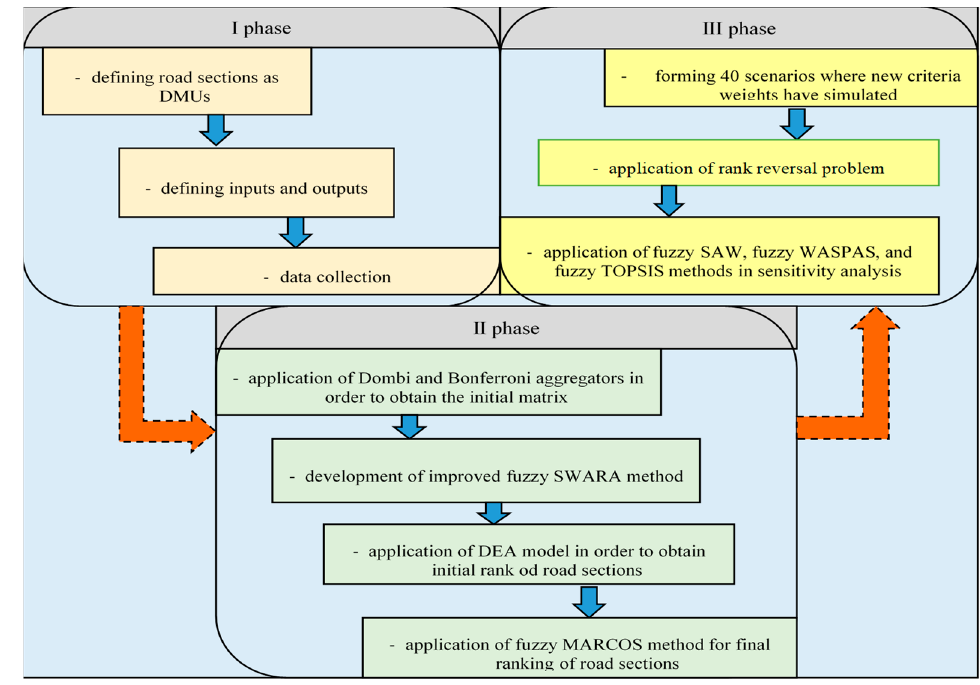
Figure 1. Research flow diagram with the applied methodology.